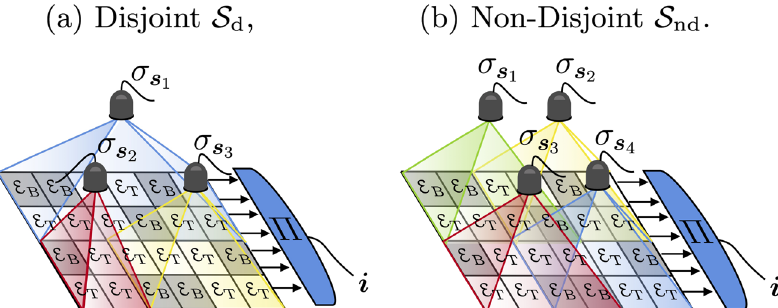
Fig. 1 Unassisted block protocols. a Disjoint vs. b non-disjoint multipartite probe-domain distributions assuming the use of single-copy probe states, M = 1. In a , there are clearly no overlapping probe domains and it therefore generates a fi xed block protocol. Contrarily, the overlapping probe domains in b gives rise to a dynamic block